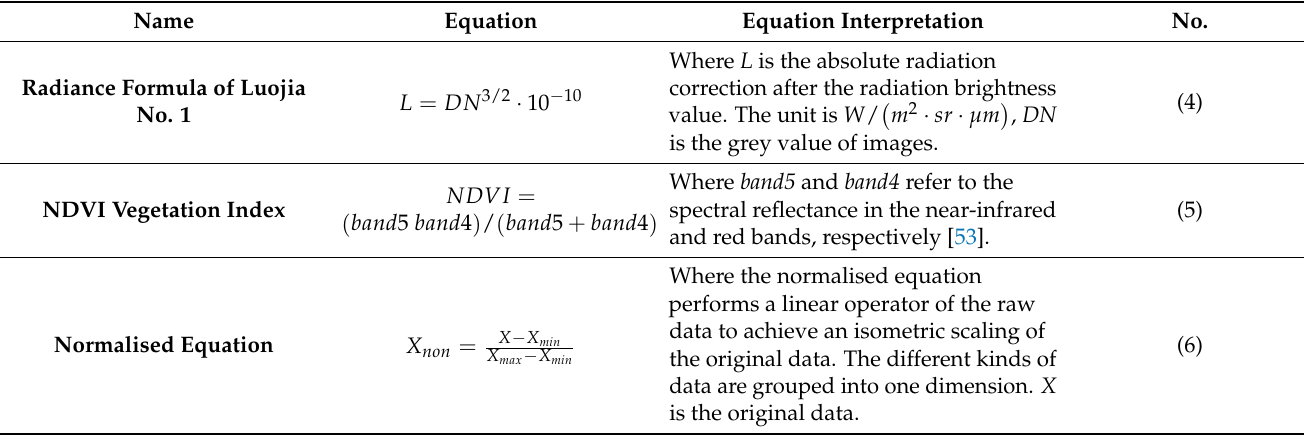
Table 2. Data normalisation